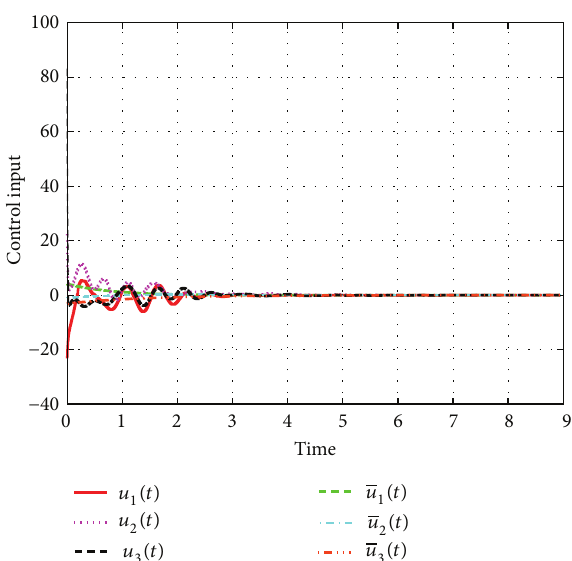
Figure 4: Time histories of 𝑢 𝑖 (𝑡) and 𝑢 𝑖 (𝑡)